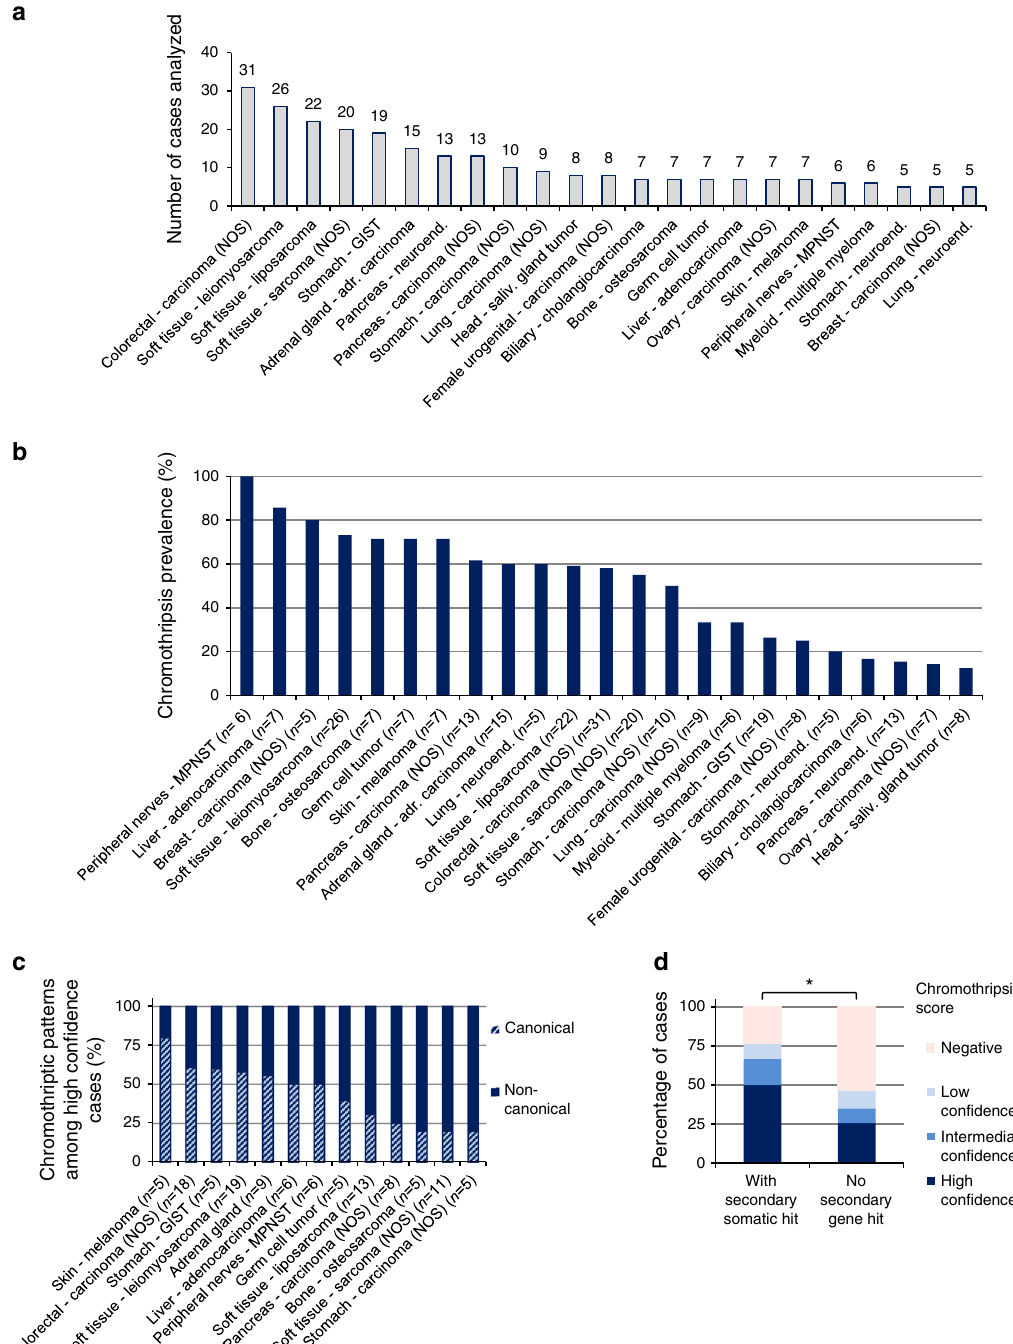
Fig. 2 Tumour entities represented in the cohort and chromothripsis prevalence across entities. a Number of analysed cases for each tumour entity ( n = 316 whole-genome sequences in total, with 263 cases for entities with at least 5 cases per entity). Tumour entities with less than 5 cases per entity are shown in Supplementary data 1. b Chromothripsis prevalence (high con fi dence) per tumour entity for all entities with at least 5 cases ( n = 263). c Distribution of canonical versus non-canonical chromothripsis, from all cases with high con fi dence chromothripsis scoring ( n indicates the number of high con fi dence chromothriptic cases per tumour entity for all entities with at least 5 high con fi dence cases). d Chromothripsis prevalence among cases with germline mutations in cancer predisposition genes ( n = 74 cases, whole-genome and whole-exome sequences). Statistical signi fi cance was tested using Fisher exact test (* p < 0.05, two-sided). MPNST malignant peripheral nerve sheath tumour; GIST gastrointestinal stromal tumour; NOS not otherwise speci fi